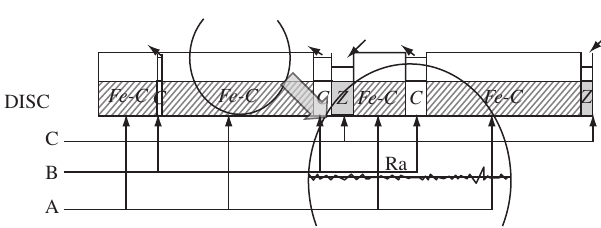
Figure 13. Physical model of the grey cast iron brake disc: Fe-C - metallic structures, C - graphite flake, Z - pits, black arrows - removal of graphite, brown arrows, compaction and storage of wear debris.